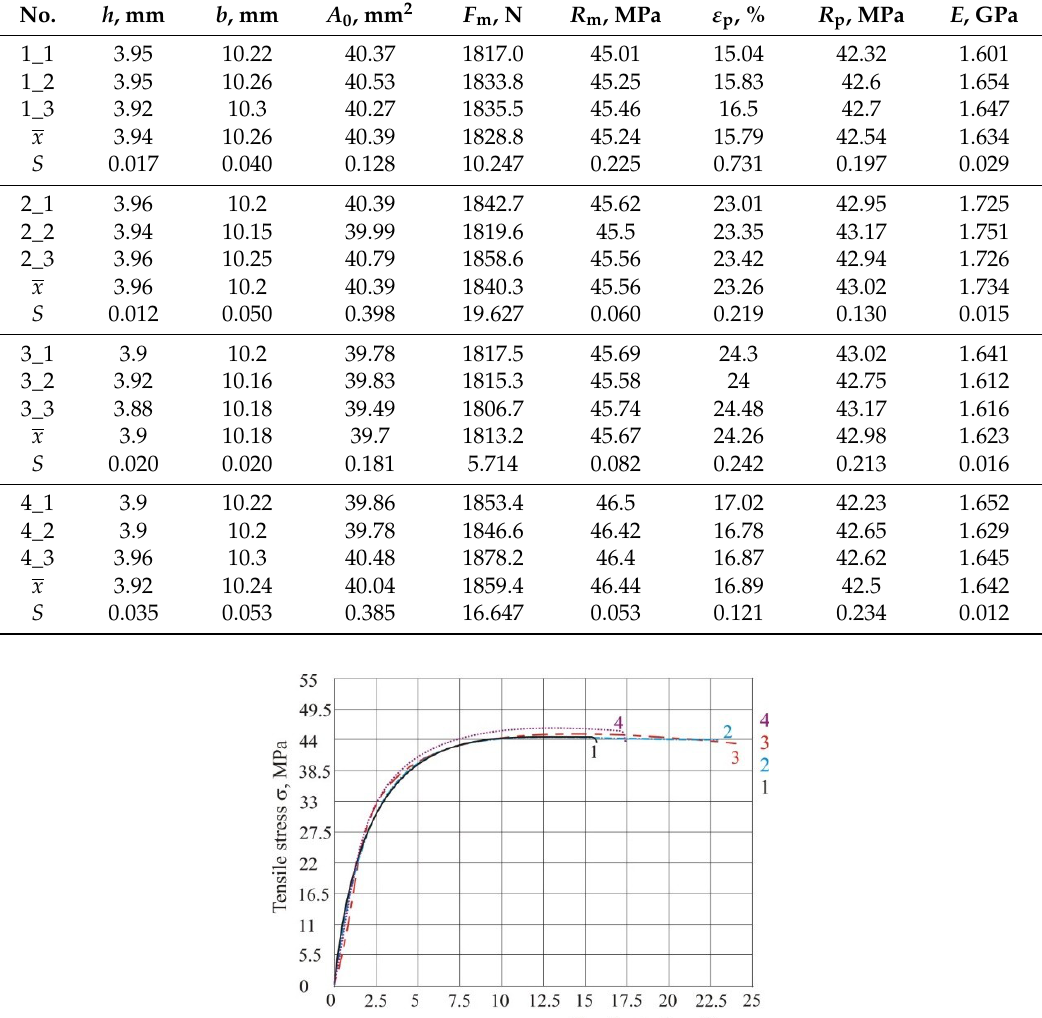
Table 3. Tensile properties with the same value of energy density and overlay ratio.